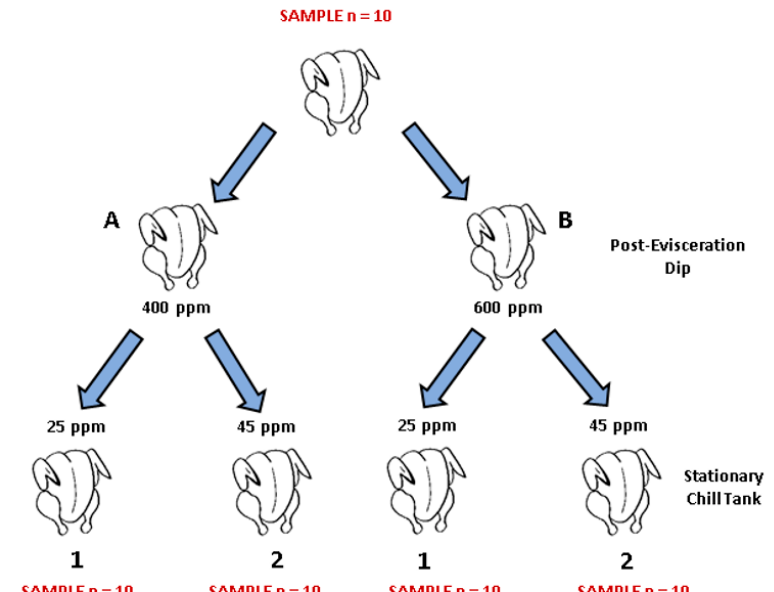
Figure 1. Schematic of the sampling procedure followed in the current experiment. A total of 150 broilers were processed at the University of Arkansas poultry pilot processing plant, where sampling took place. For each PAA sanitizer tested (PeraClean, Competitor 1, and Competitor 2), ten birds were rinsed in 400 mL of neutralizing buffered peptone water (nBPW) for 1 min by manual shaking after manual evisceration took place and were discarded. Following this, forty birds were eviscerated and dipped in solution containing 400 or 600 ppm of PAA for ten seconds immediately after evisceration and then placed into four separate stationary chillers containing either 25 or 45 ppm of PAA sanitizers for 1 h. After birds had been chilled, carcasses were rinsed in nBPW and discarded. Rinsates were collected in specimen cups, stored on ice, and transported to the Center for Food Safety at the University of Arkansas for processing.